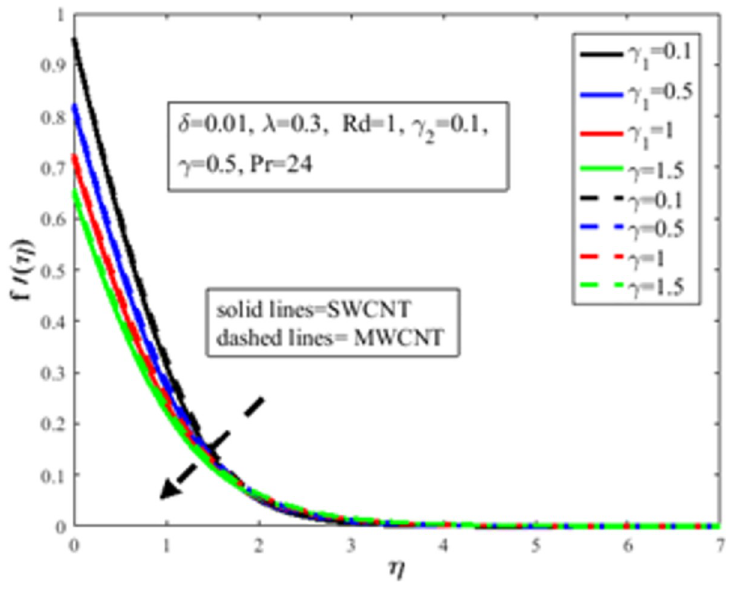
tue of an increment in the concentration of nanoparticles. Concentration of the fluid increases